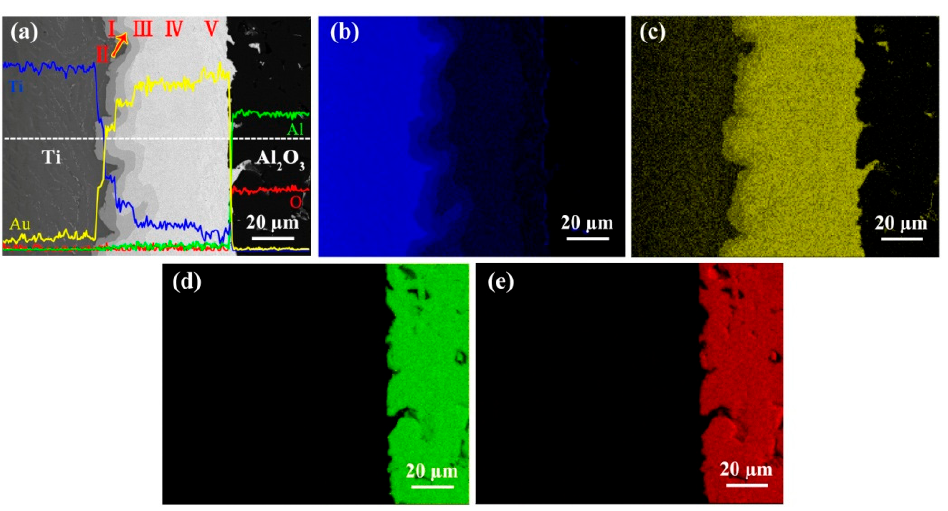
Figure 2. Microstructure and corresponding element distribution of the titanium/Au/Al 2 O 3 joint brazed at 1115 °C for 1 min. ( a ) Microstructure and elemental distribution maps of ( b ) Ti, ( c ) Au, ( d ) Al, and ( e ) O.